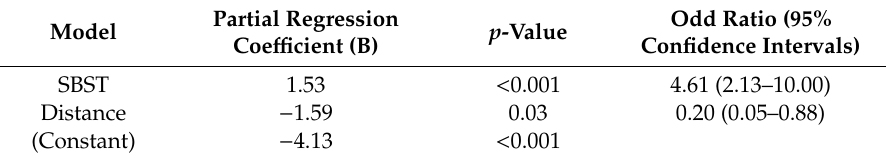
Table 4. Results of logistic regression modeling to estimate whether the patient lost the mechanical diagnosis and therapy follow-up with the mechanically inconclusive subgroup before the fifth session or not.